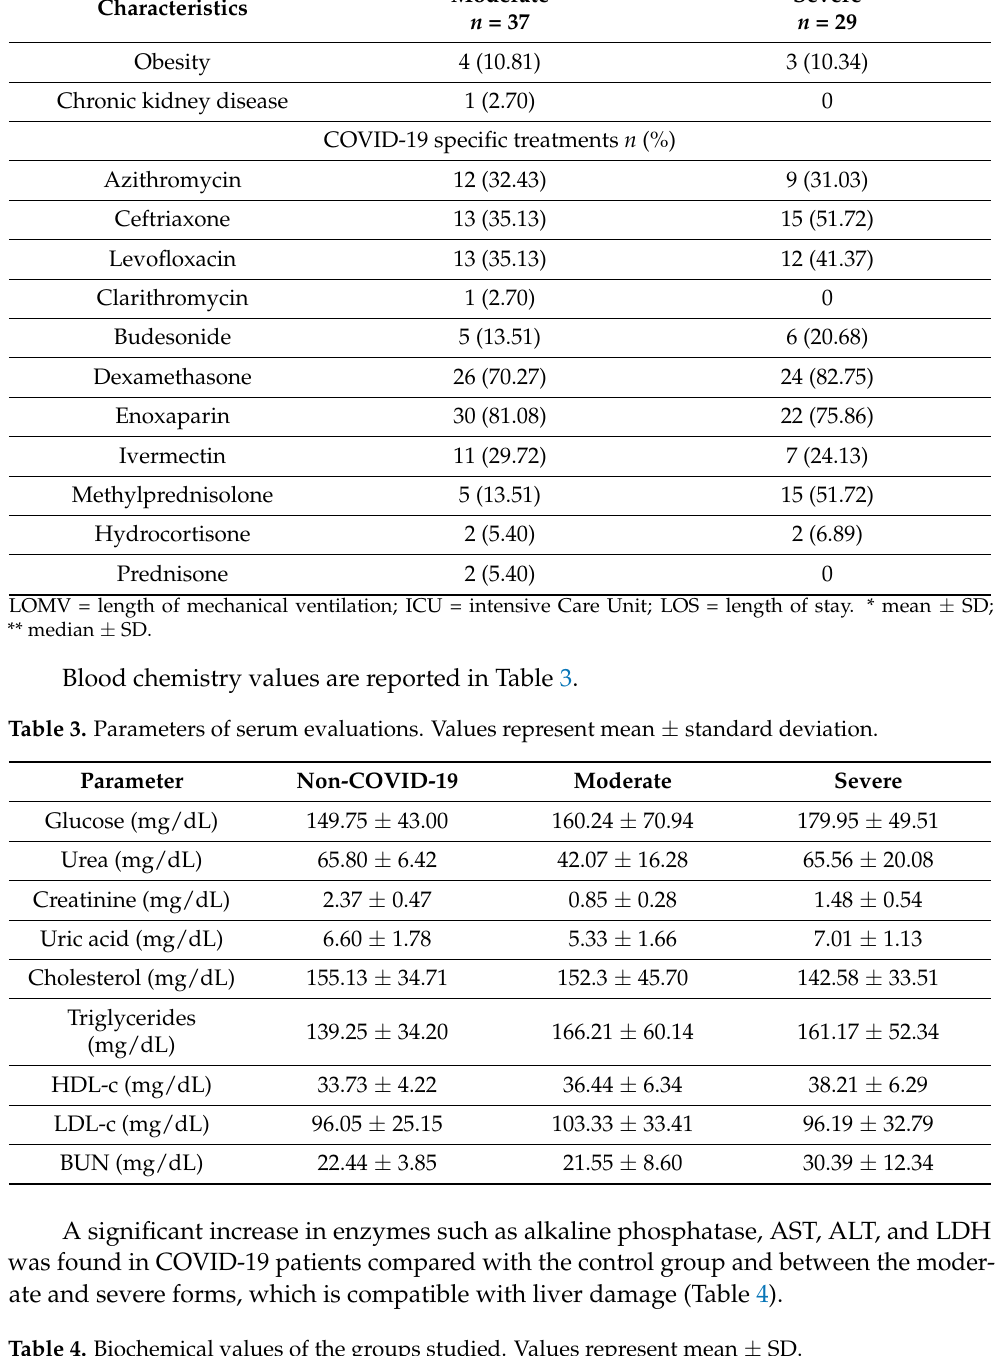
Table 4. Biochemical values of the groups studied. Values represent mean ±